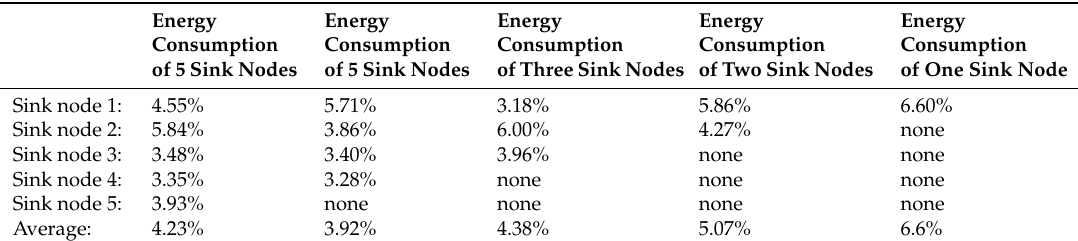
Table 4. Energy consumption.